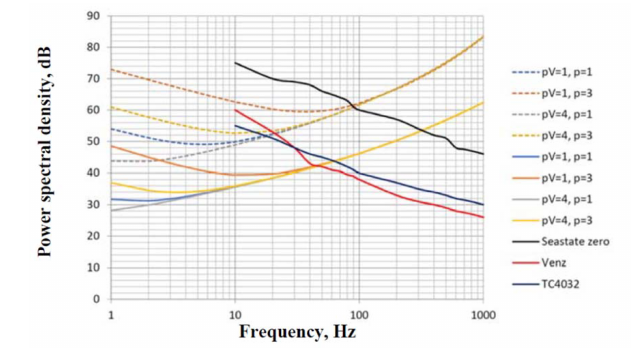
Figure 6. METH noise modelling for different pV and p parame- ters of the METH air chamber in comparison with the Wenz model (Wenz, 1962) and some modern piezo hydrophones (TC-4032, available at: http://www.m-b-t.com, last access: 12 July 2018). Hz √ – x axis, dB (re 1µPa/ Hz) – y axis.